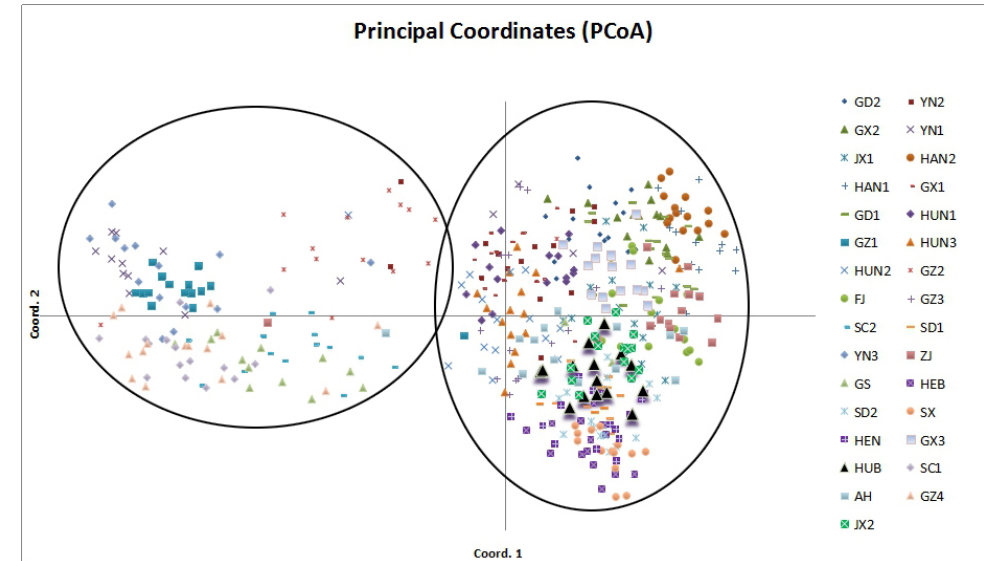
Figure 5. Biplots of PCoA1 and PCoA2 within 31 Melia provenances.